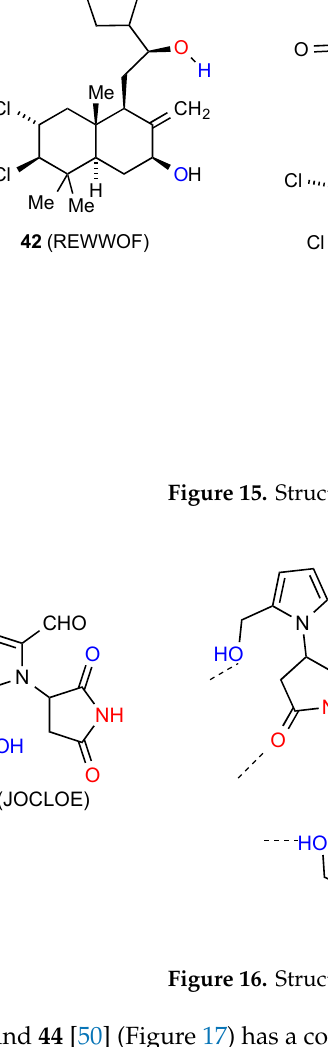
Figure 16. Structure observed for compound 43.